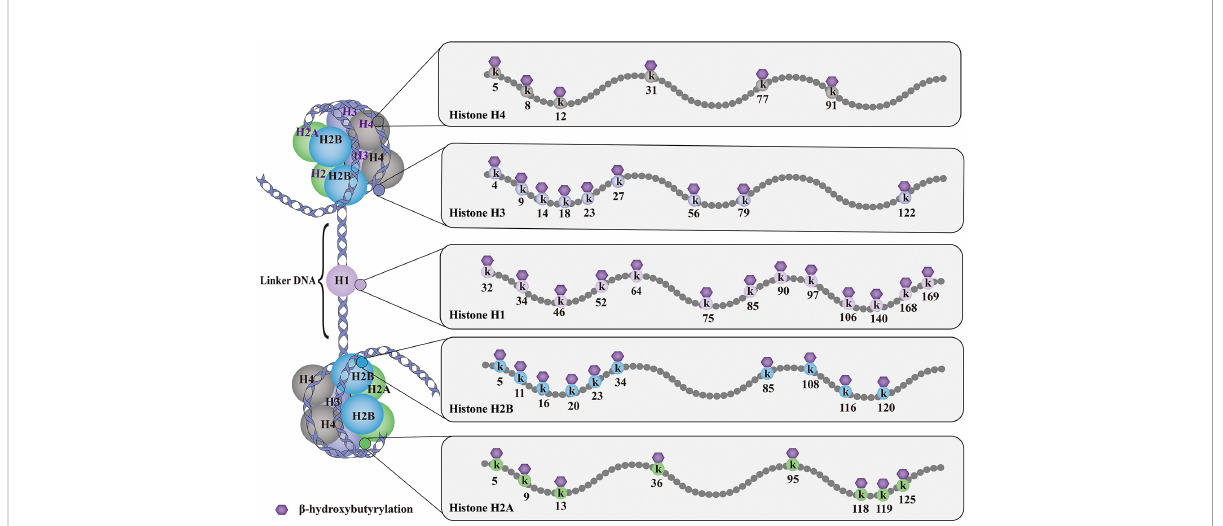
FIGURE 1 Histone Kbhb sites on histones. The basic subunit of chromatin is the nucleosome, which comprises an octamer of two copies of each of the core histone proteins (H2A, H2B, H3 and H4) wrapped by 146 bp of chromosomal DNA. Till now, histone Kbhb have been detected in four core histones (H3, H4, H2A and H2B) and linker histone H1 in yeast, fl ies, mice, and human cells, and a total of 46 histone Kbhb sites have been identi fi ed in vivo and vitro . These histone Kbhb modi fi cation sites cross-talk in fl uence on other types of HPTMs dynamically in health and